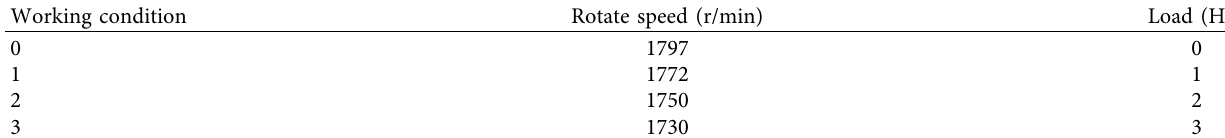
Figure 6: Te detection process of MW-CAVE. Table 2: Four working